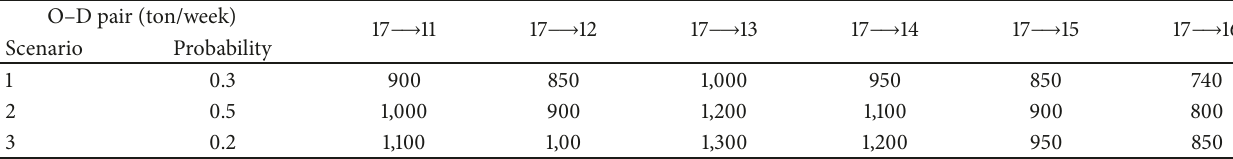
Table 6: O–D demands in the network.